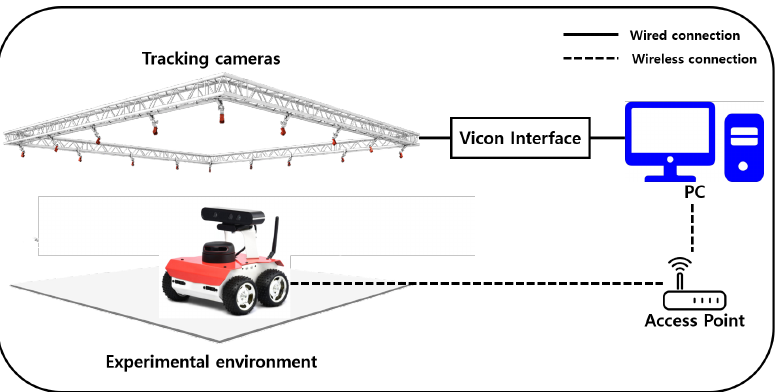
Figure 5. Experimental setup. The PC is connected to the robot wirelessly and the Vicon Tracker by